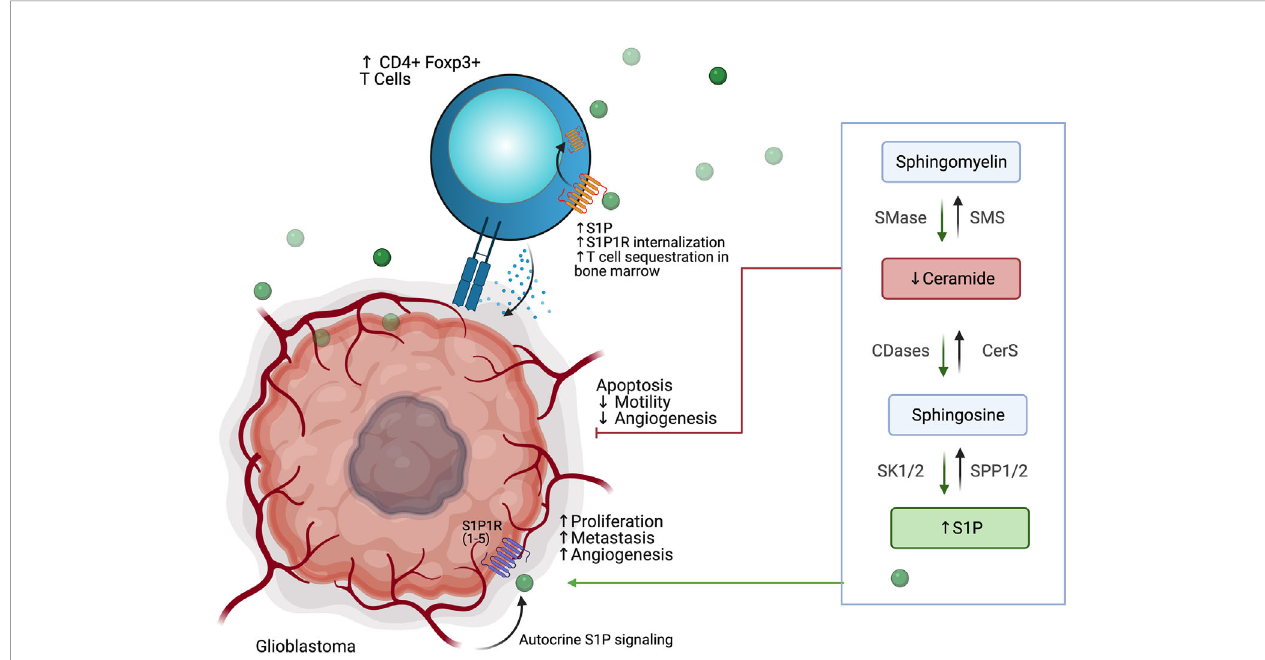
FIGURE 5 | 2 HG produced by IDH1/2 mutant secondary glioblastoma promotes tumor survival while impairing T cell activation and